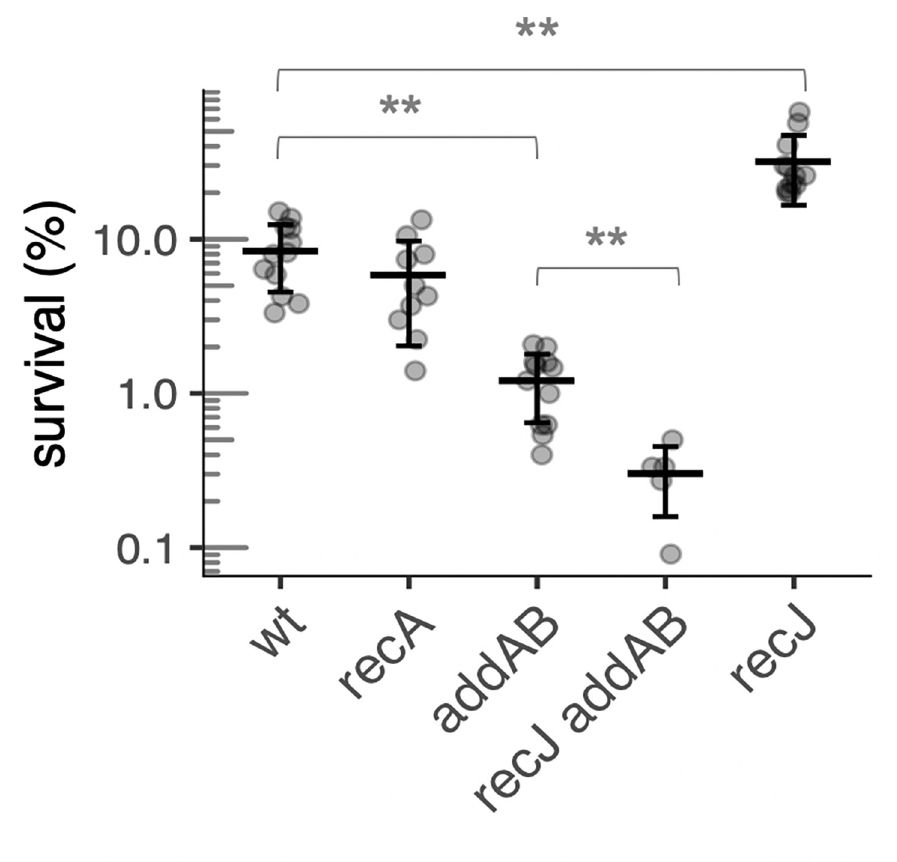
Fig 4. Effect of RecA and end-resection on survival of HPUra-induced replication arrest, in the absence of phages. Percent survival after 3 h of replication arrest for wild-type (LSF225), and recA (LSF658), addAB (LSF254), recJ addAB (LSF648), and recJ (LSF231) null mutants. �� Statistically different means, by two-tailed t-test (P < 0.005).